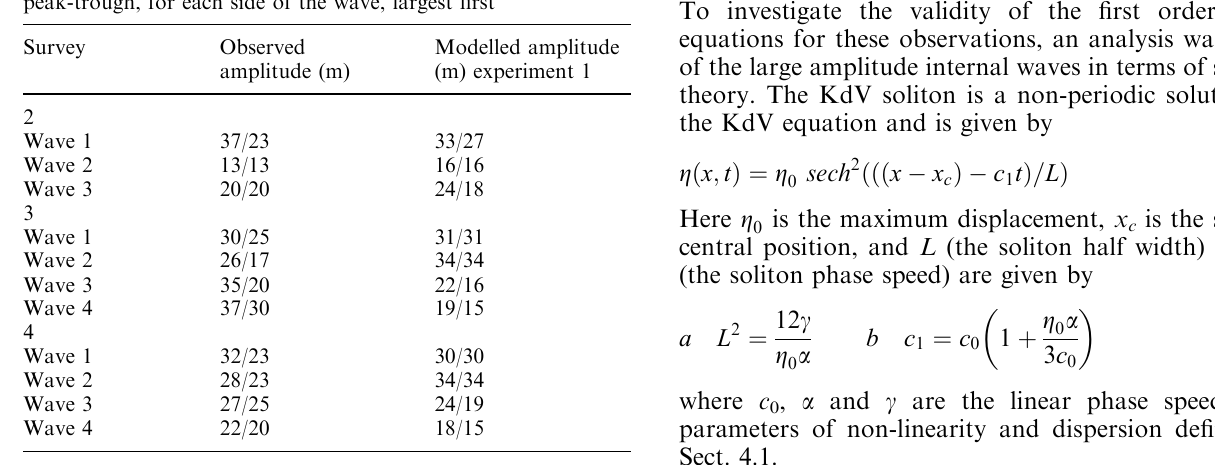
Table 4b. Comparison of observed (Table 1) and modelled phase speeds of the leading wave in the bore. The observed value for Sect. 3–4 is only approximate (see Sect. 2.2)